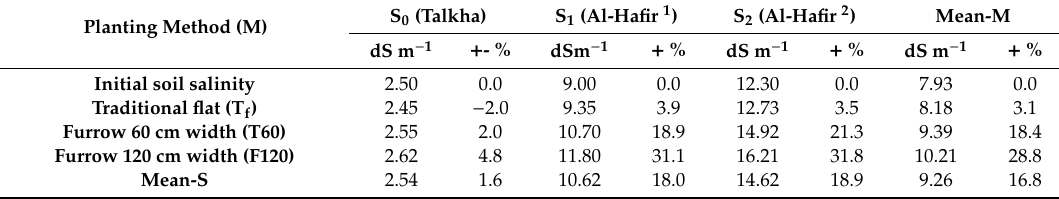
Table A1. Soil salinity after harvesting under di ff erent planting methods and salinity conditions. Planting Method